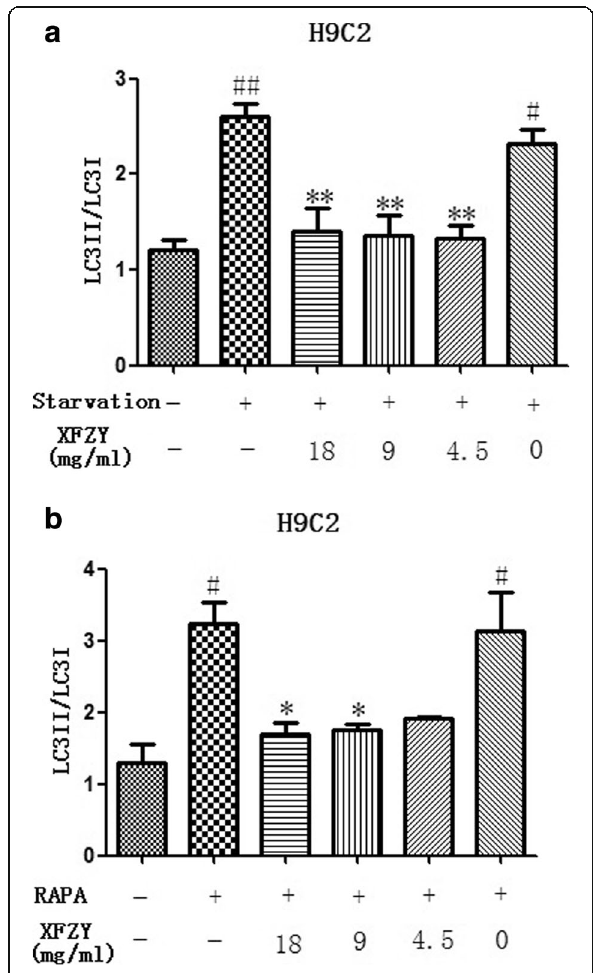
Fig. 8 XFZY inhibited starvation/rapamycin-induced autophagy in H9C2 cells. a Cells were incubated in serum-free medium in the absence or presence of XFZY for 10 h, and the protein expression of LC3 was assayed. b Cells were incubated with rapamycin (500 nm) in the absence or presence of XFZY for 10 h, and the protein expression of LC3 (normalized to that of GAPDH) was assayed. *p < 0.05, **p < 0.01 vs Control group; # p < 0.05, ## p < 0.01 vs Vehicle